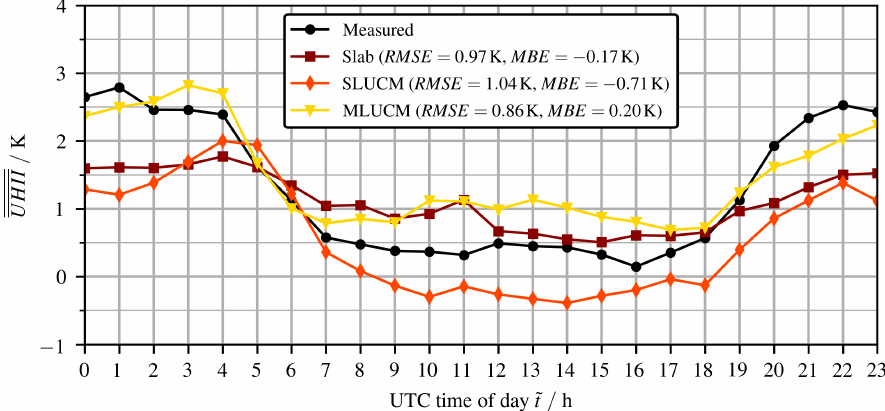
Figure 4. Urban heat island (UHI) intensity profiles for an average day comparing the three different urban models to